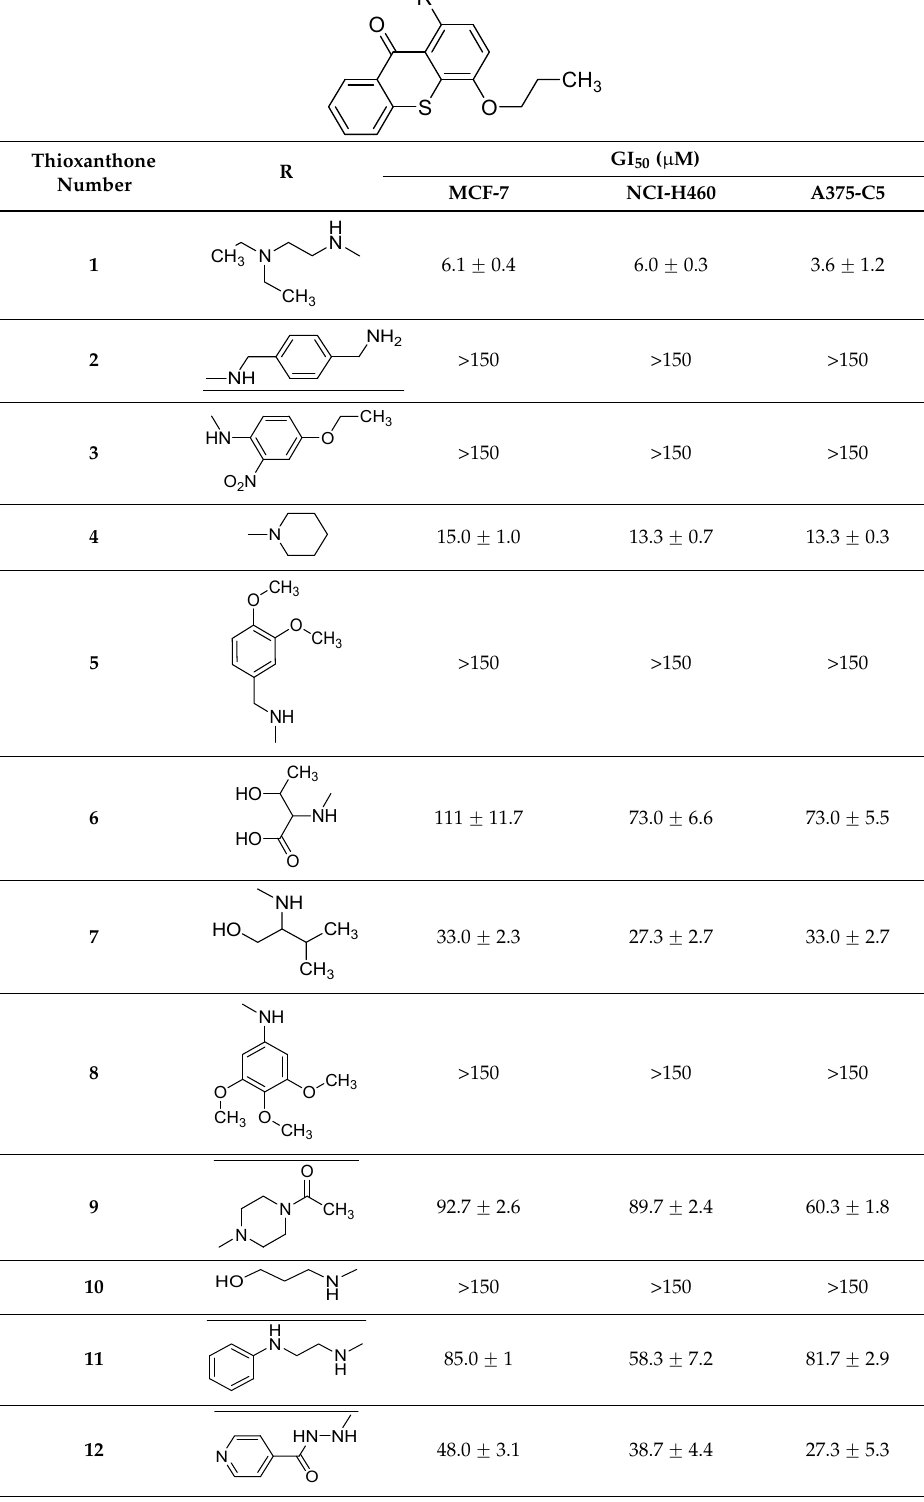
Table 1. GI 50 values determined for the 27 thioxanthones following continuous treatment of the three human tumor cells lines during 48 h.